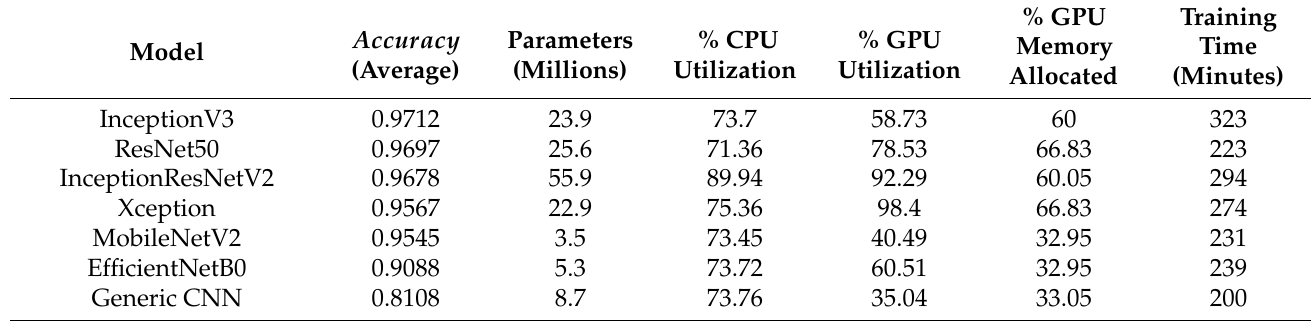
Table 7. Computational complexity of the models trained in this study.